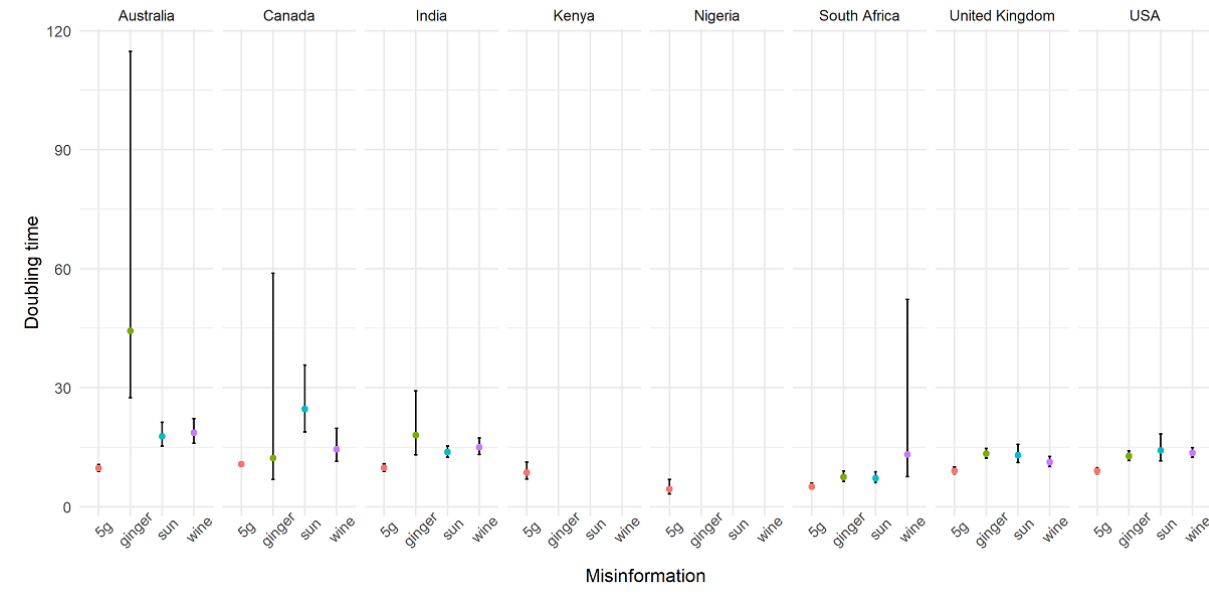
Figure 2. The estimated doubling time for searches on four misinformation topics: 5G, wine, ginger, and